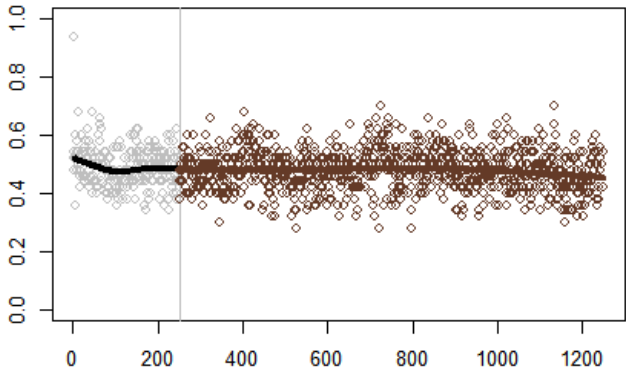
Figure 12. Burn-in iteration for MCMC computing.